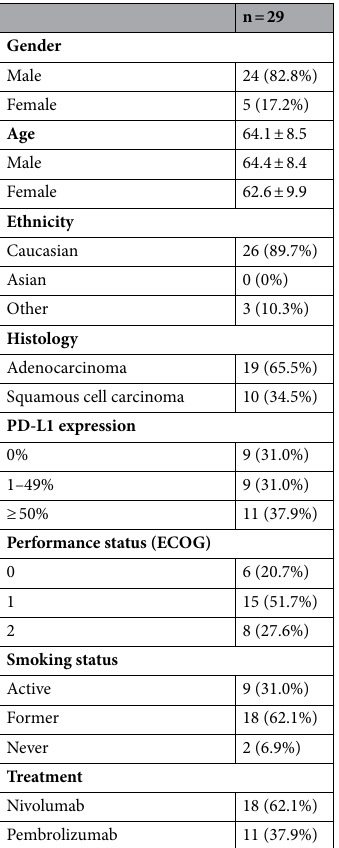
Table 2. Patients’s baseline characteristics. Table 1 summarizes the baseline characteristics of the study cohort. ECOG European Cooperative Oncology Group, PD-L1 Programed death ligand